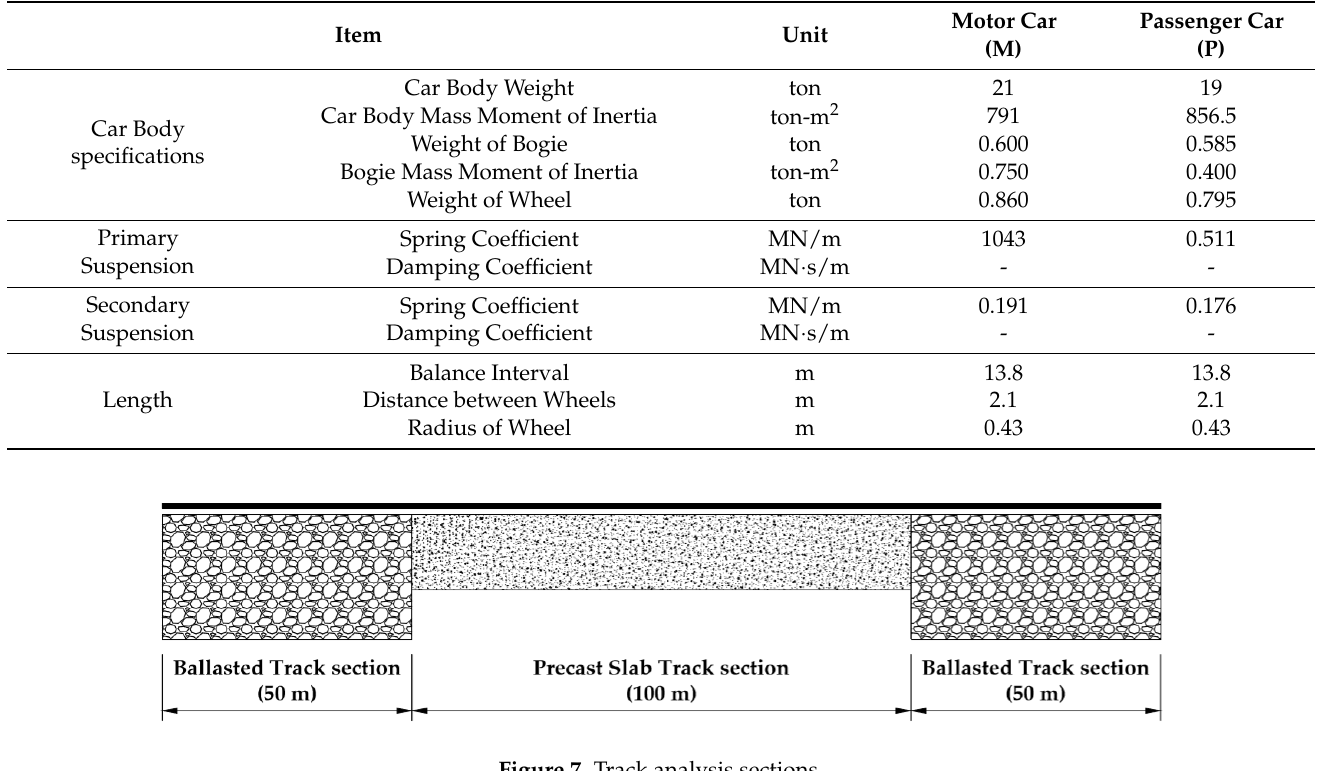
Table 2. Specification of trainset (half model).